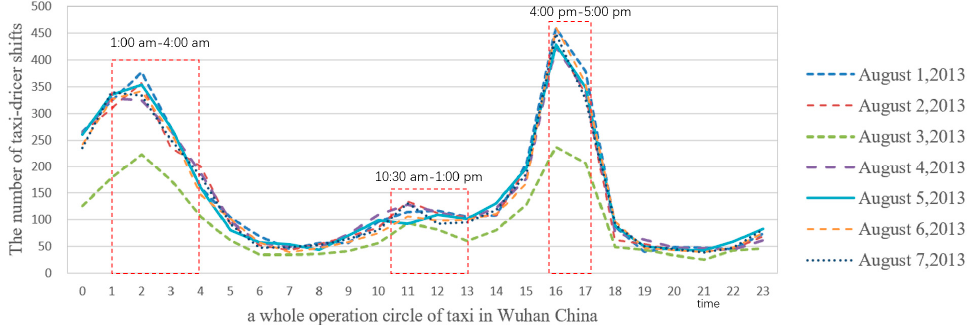
Figure 8. Temporal distribution of taxi-driver shift events in Wuhan, China from 1–8 August 2013.